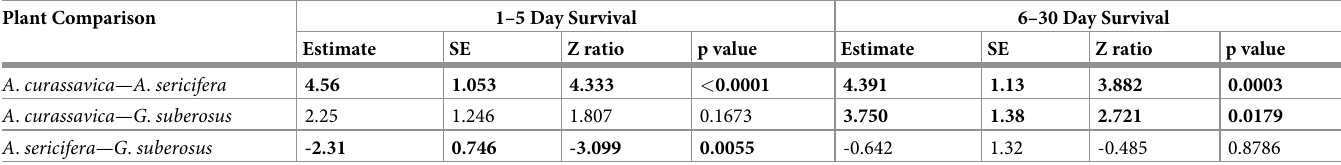
Table 3. Pairwise Tukey post-hoc tests on the estimated marginal means of modeled larval survival from 1–5 and 6–30 days after hatching. Plant Comparison